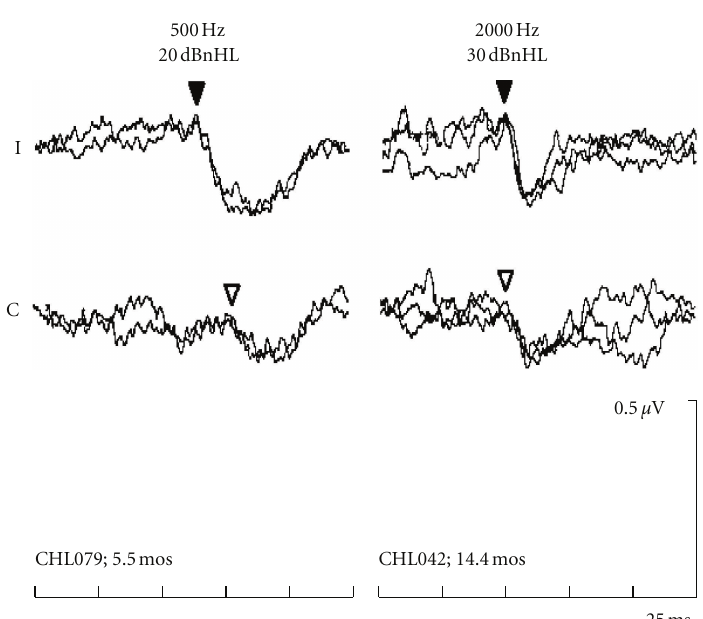
Figure 1: ABRs to 500 and 2000 Hz BC tones, presented at 20 and 30 dBnHL respectively, recorded from two infants with conductive hearing loss at the time of ABR testing. Age at ABR testing indicated on the bottom. These infants had normal hearing to air-conduction stimuli at behavioural followup. “I” equals the ipsilateral channel (EEG channel ipsilateral to the BC transducer). “C” equals the contralateral channel (EEG channel contralateral to the BC transducer). Waves V are indicated by the triangles (filled = ipsilateral; open = contralateral).